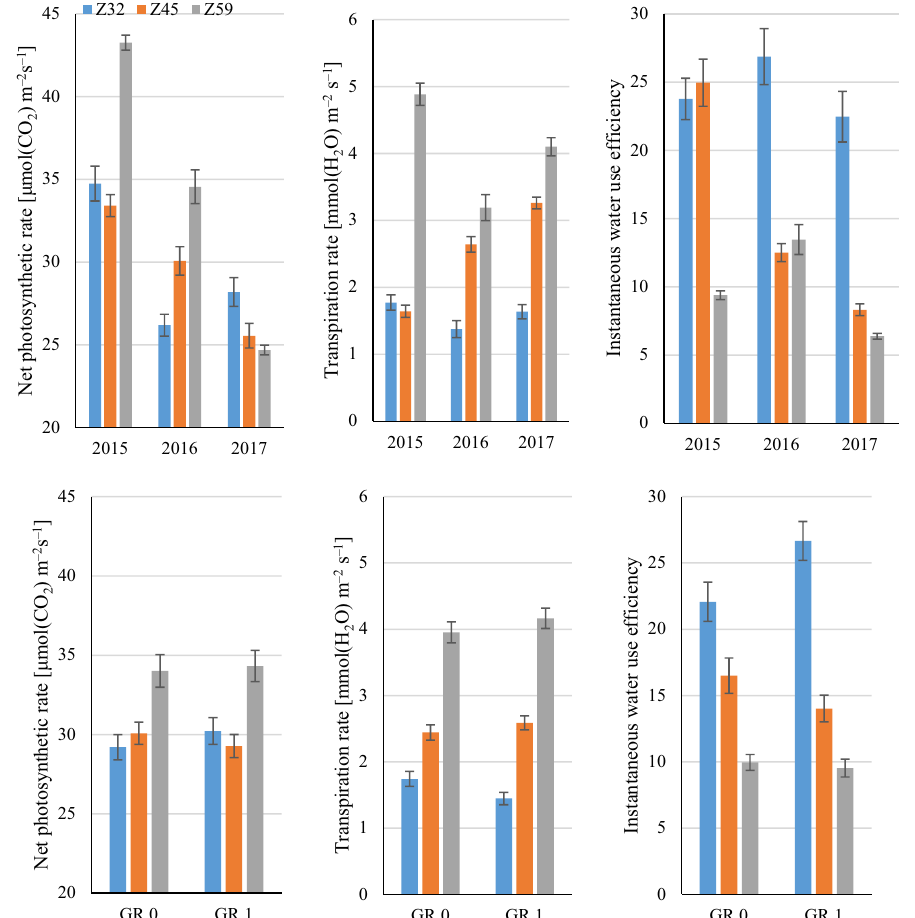
Figure 2. Mean values and standard error of photosynthesis indicators for year × growth stage (upper) and growth regulator × growth stage interactions (GR 0—without growth regulator, GR 1—with growth